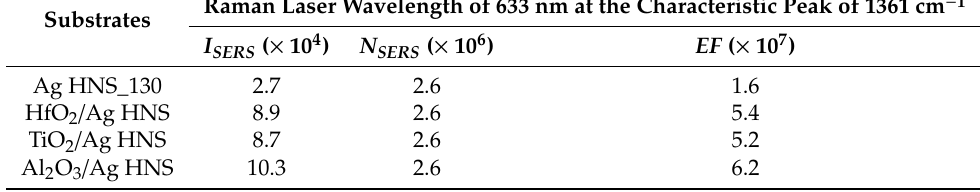
Table 1. The EFs of various substrates, obtained from Figure